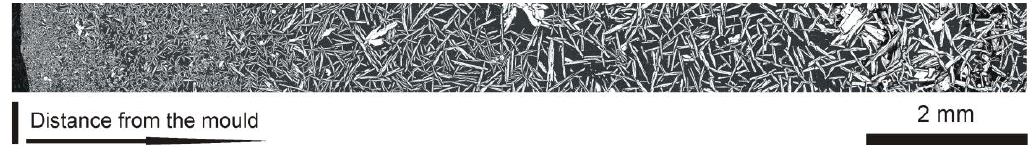
Figure 6. Microstructure evolution with distance from the wall of the mould in the bottom part of the W–Al-VIM-1 ingot. Molecules 2020 , 25 , x